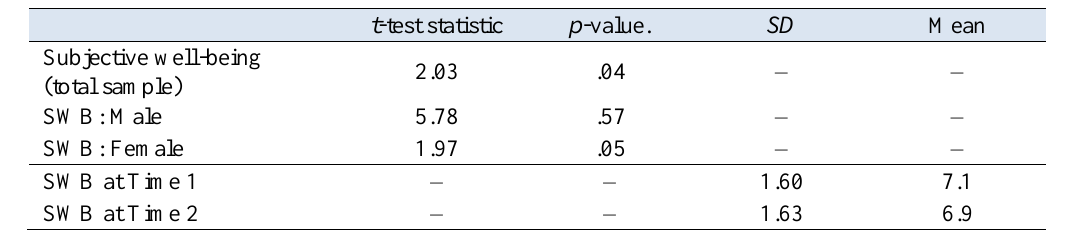
Paired-samples t-test results and comparison of means t -test statistic p -value.